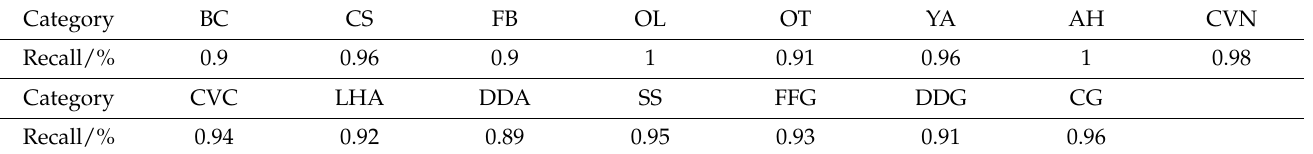
Figure 12. Confusion matrix of classification results of each category. The horizontal axis is the predicted label, and the vertical axis is the true label. Darker colors correspond to larger values. Table 3. Recall rate of each category on ORSC-15 dataset. The recall rate of each category is relatively balanced, and the influence of the long-tailed distribution is reduced to a very low level.